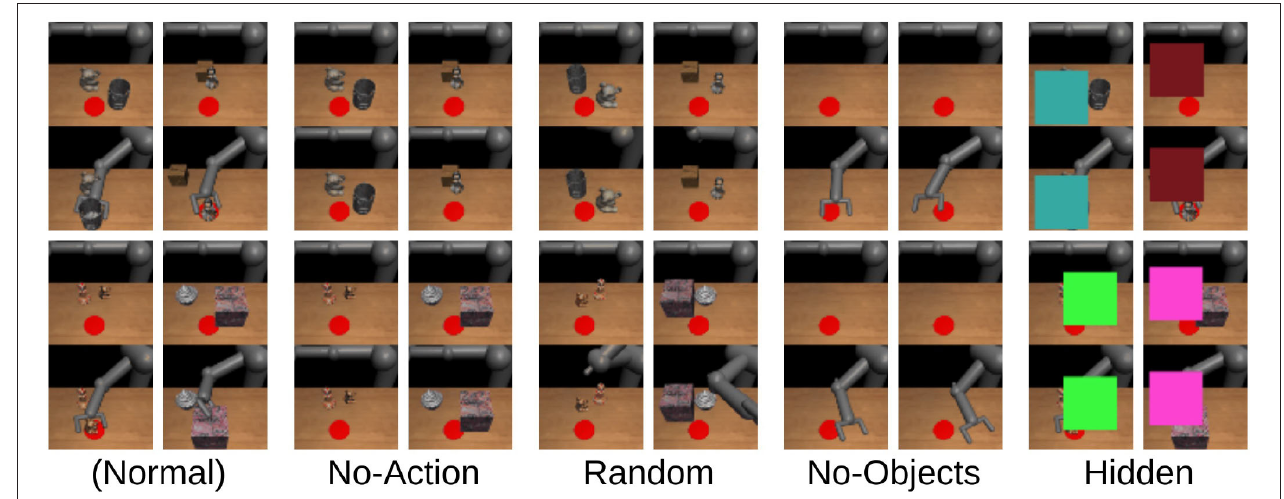
FIGURE 4 | Examples of synthesized out-of-distribution demonstrations (the normal demonstrations are from the original datasets).